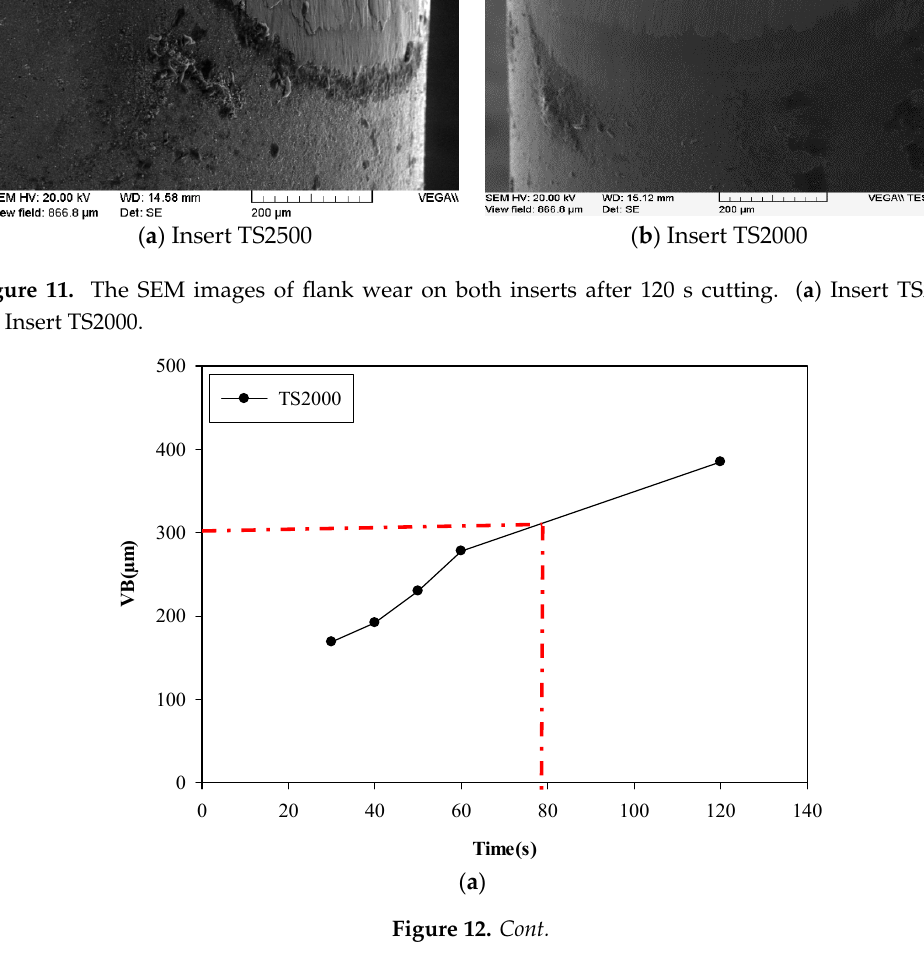
Figure 11. The SEM images of flank wear on both inserts after 120 s cutting. ( a ) Insert TS2500. ( b ) Insert TS2000 .